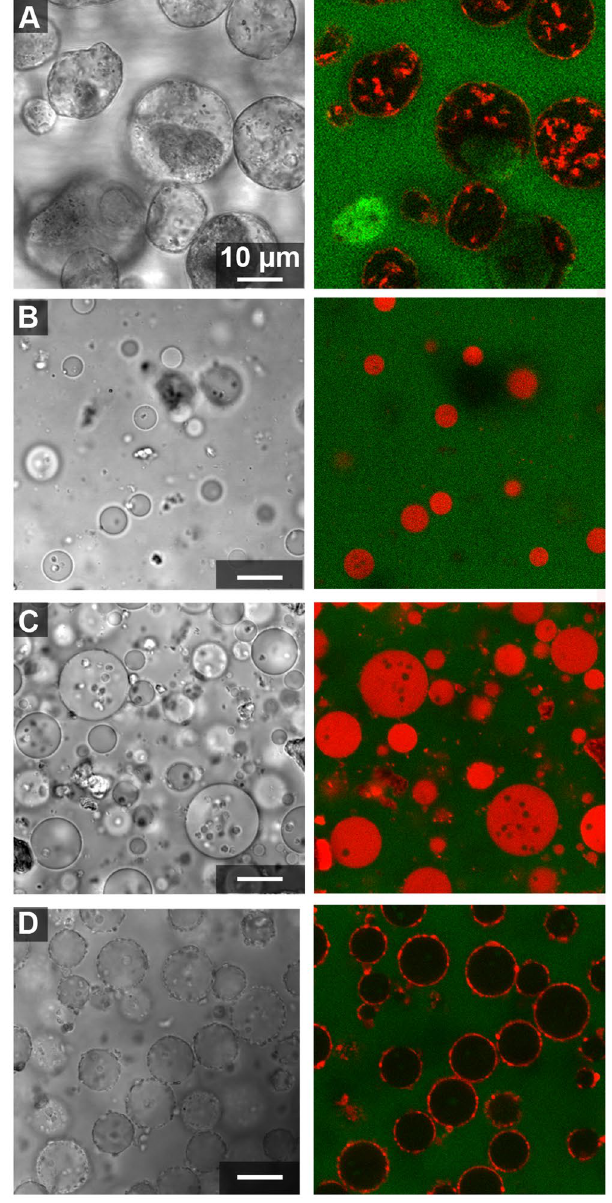
Figure 5. Clay distribution in ATPS with higher polymer concentration. Optical microscope images showing clay particles with 20:1 volume ratio of a stock 20%/20% w/w PEG/Dx ATPS. Left-hand images show transmitted light, and right-hand images show overlay of red and green confocal fluorescence channels for samples containing: ( A ) Kaolinite, ( B ) Na-rich montmorillonite, ( C ) Ca-rich montmorillonite and ( D ) illite. Fluorescent-labeled Dx (red) and PEG (green) have been included to aid visualization of the Dx-rich phase droplets and PEG-rich continuous